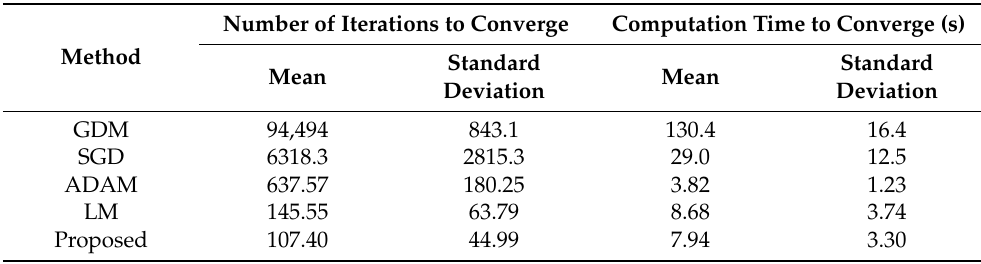
Table 2. Training performance for the pH process after 100,000 iterations—number of iterations and computation time of hidden layer with 7 nodes.